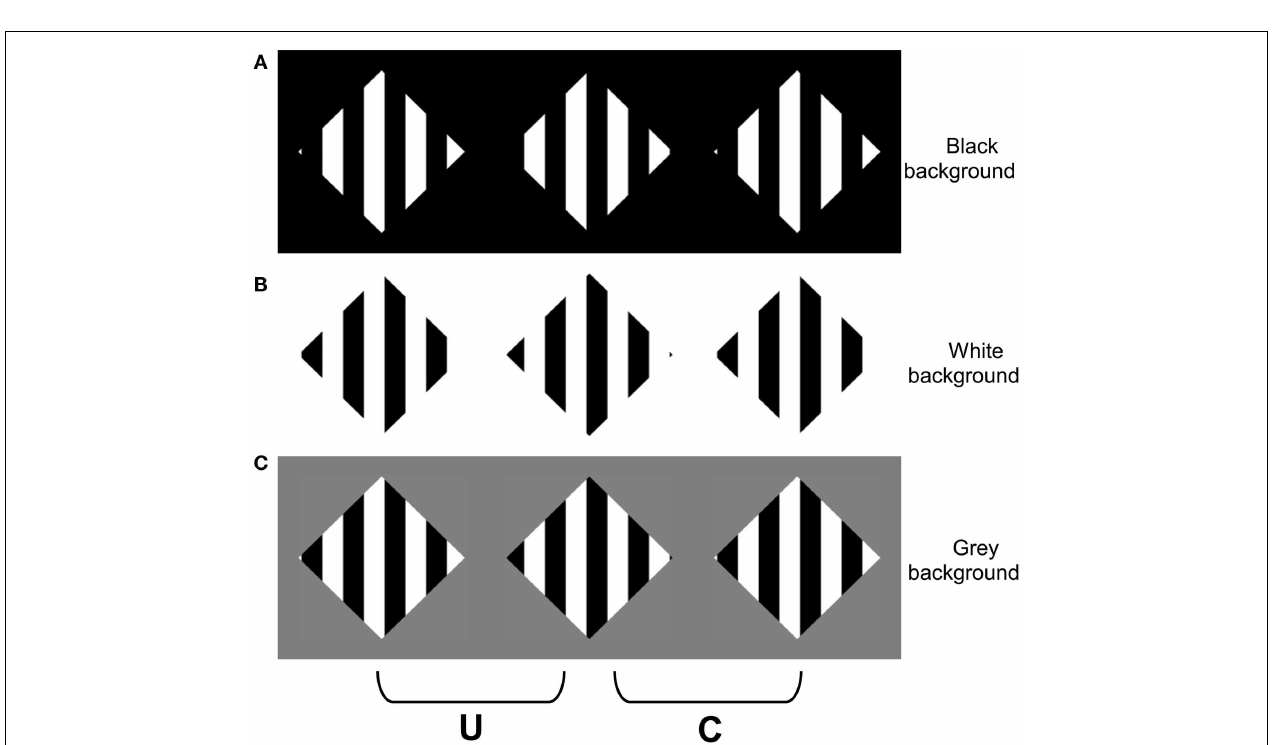
white diamond occluded by black stripes, (B) appears as a black diamond occluded by white stripes, and (C) appears